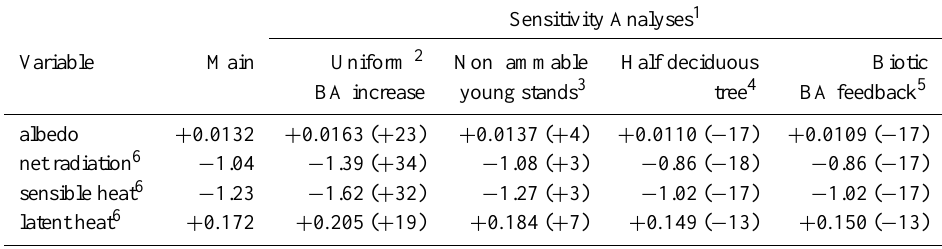
Table 5. Differences in annual energy budgets between BA × 2 and BA × 1 for the main simulations and four sensitivity analyses.